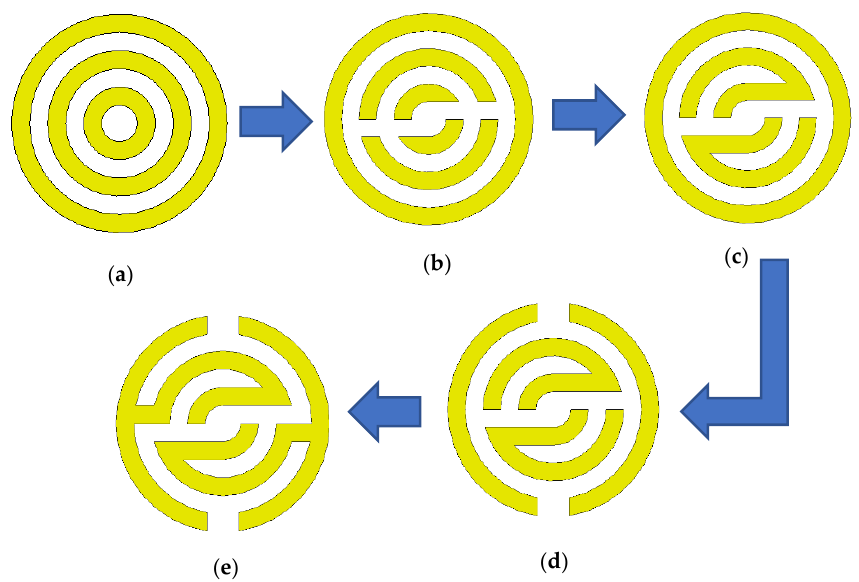
Figure 2. Schematic views for the evaluation of the proposed MTM.